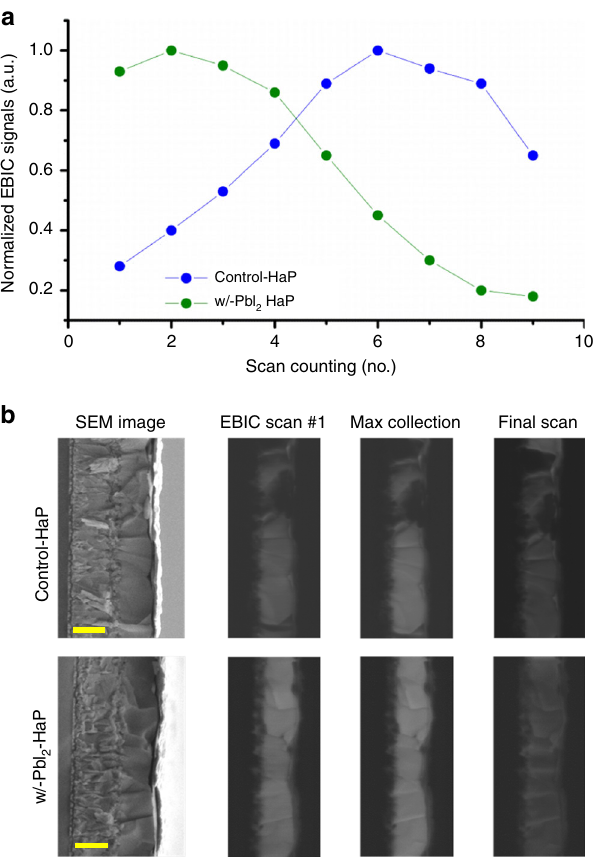
Fig. 2 The changes in the EBIC signal during repetitive scans of cross- sectional samples. a Normalized EBIC signal vs. scan number for control- HaP (blue) and w/-PbI 2 -HaP (green). The EBIC signal of each sample is normalized to the maximum intensity of that sample. b Cross-sectional SEM images of the two samples with EBIC mapping of the cross section after various beam exposure. Scale bars,